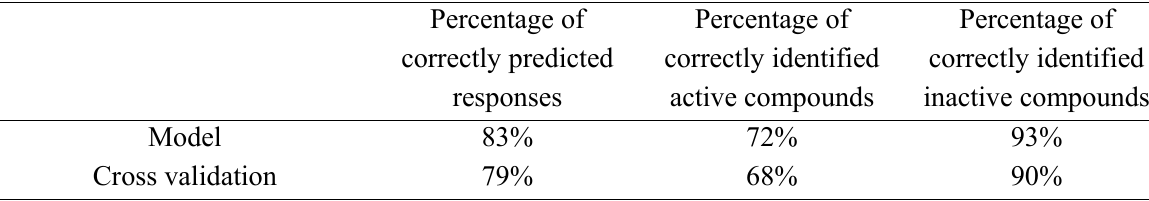
Table 3. Model Summary.